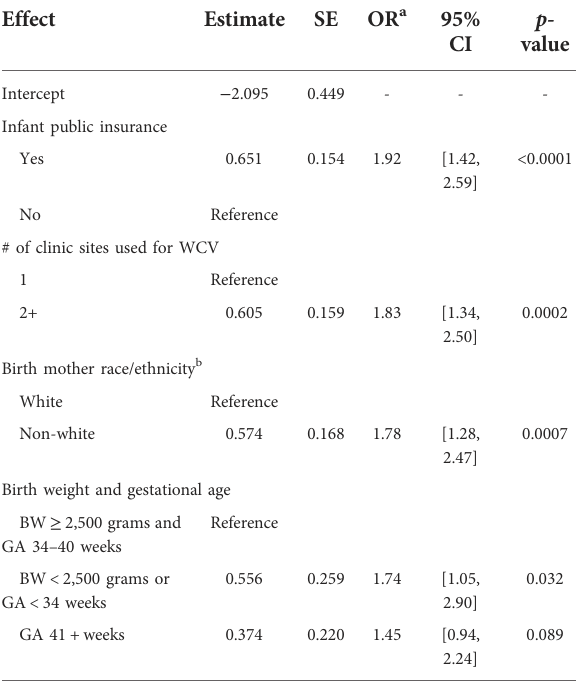
TABLE 5 Principal associations of variables that independently predict EHL